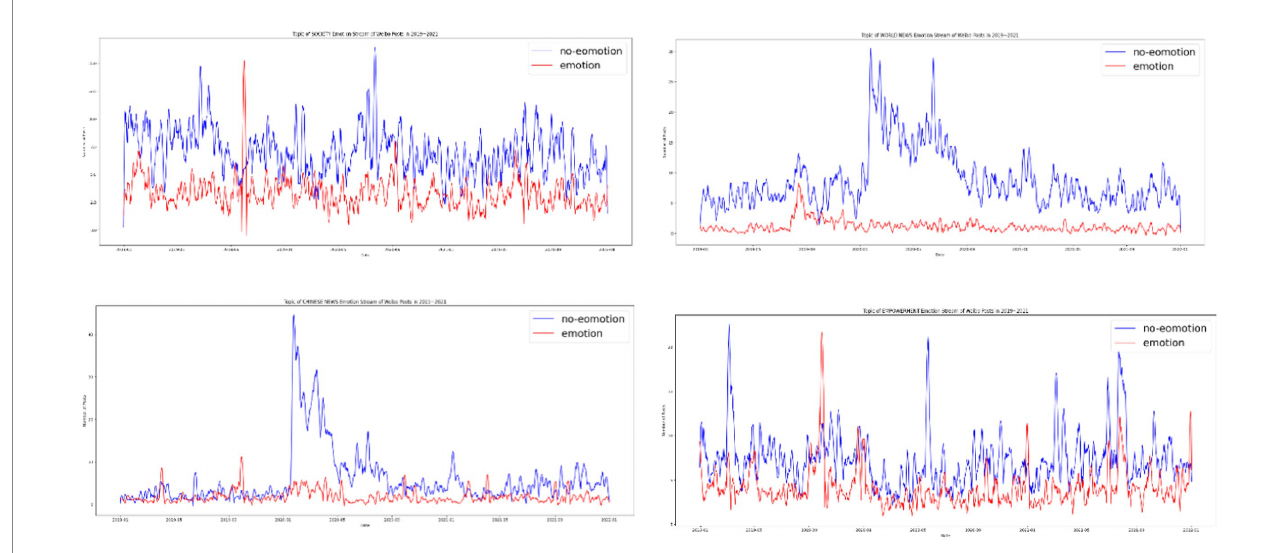
FIGURE 9 Emotionality of news over time by topic; upper left, society; upper right, world news; lower left, Chinese political news; lower right, positive energy